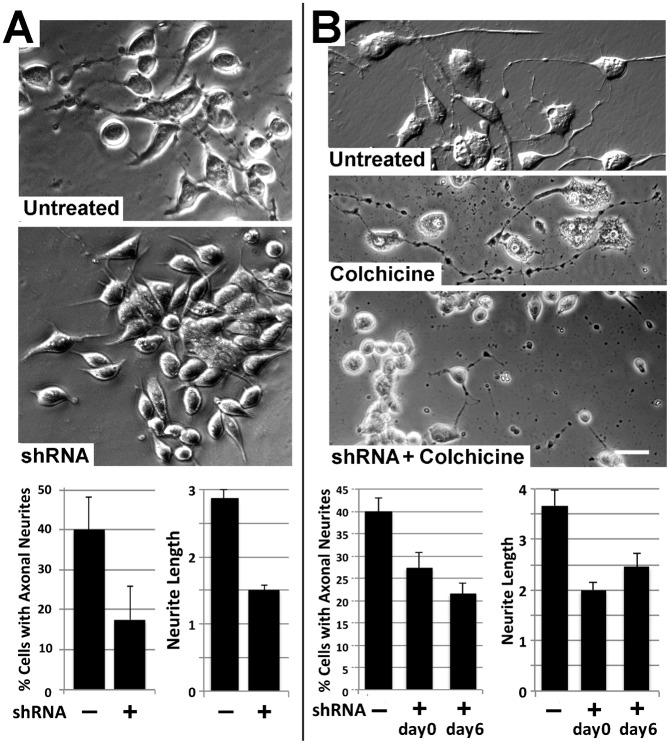
shRNA-mediated NF-H knockdown compromises axonal outgrowth and stabilization.(A) Phase-contrast images of representative fields of cells differentiated for 3 days without and with transfection with a cocktail of CDS1-4. The accompanying graphs present the mean (± standard error) the percentage of cells with axonal neurites and the length of these neurites as a function of respective somal diameters. shRNA treatment significantly reduced the percentage of cells with neurites and the length of existing neurites (p<0.01 for both versus untreated cultures; Student's t test). (B) Representative phase-contrast images of cells treated with CDS1-4 for 48 hr then differentiated for 7 days, after which alternate cultures received 1 µM colchicine for 2 hr. Colchicine treatment at this time reduces axonal neurite caliber but does not induce neurite retraction. By contrast, transfection with CDS1-4 during differentiation compromised the development of colchicine resistance. Bar: 25 µm. The accompanying graphs present the percentage of cells with axonal neurites, and the length of these neurites in respective somal diameters, following colchicine treatment without or with CDS1-4 transfection prior to differentiation (day 0) or for the final 24 hr of differentiation (day 6). Note that CDS1-4 reduced the percentage of cells with axonal neurites that resisted colchicine treatment, as well as the length of surviving neurites, when administered prior to (day 0) or following (day 6) differentiation (p<0.01 for both versus untreated cultures; Student's t test).